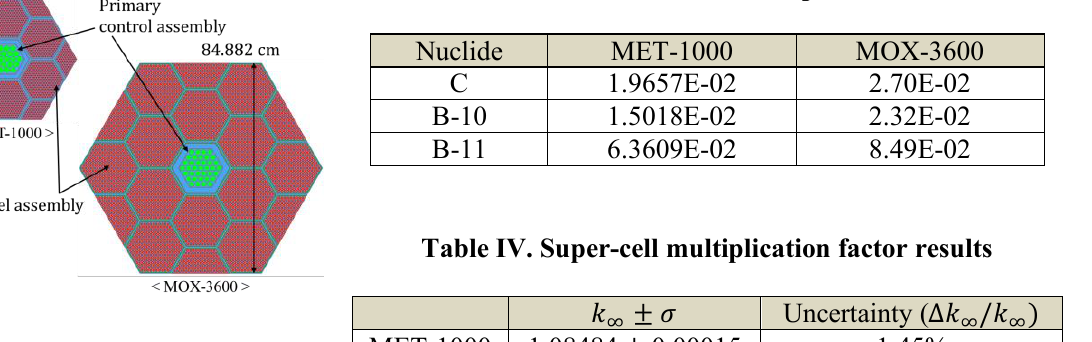
Table III. Absorber rod material composition in #/barn-cm